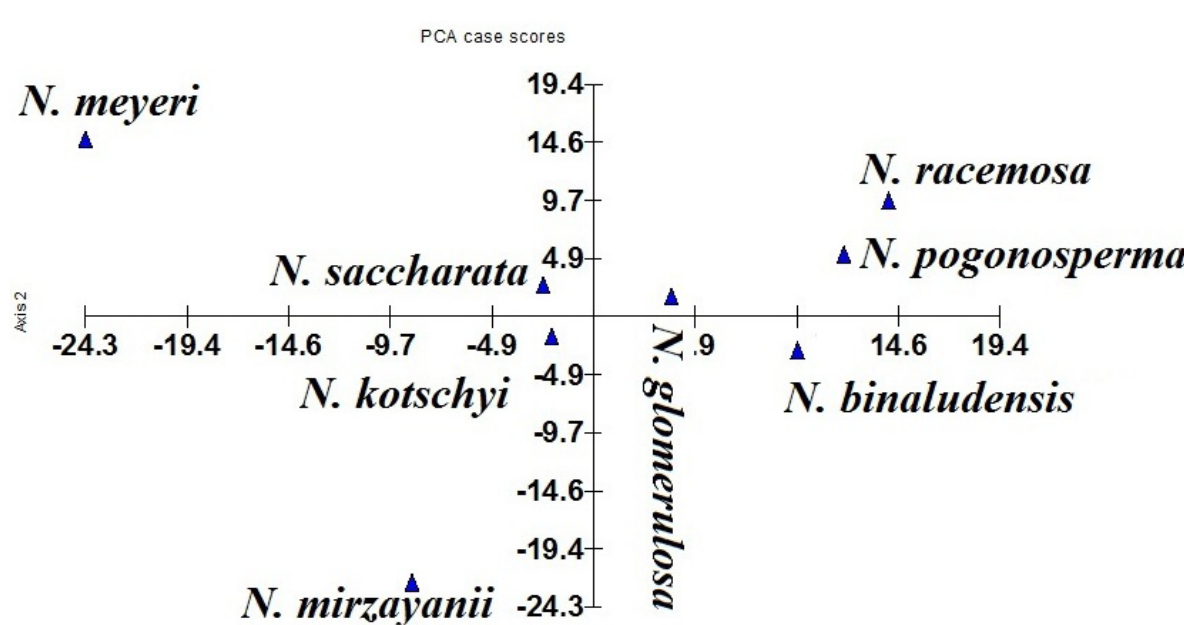
Figure 2. PCA plot of the studied Nepeta taxa based on essential oil